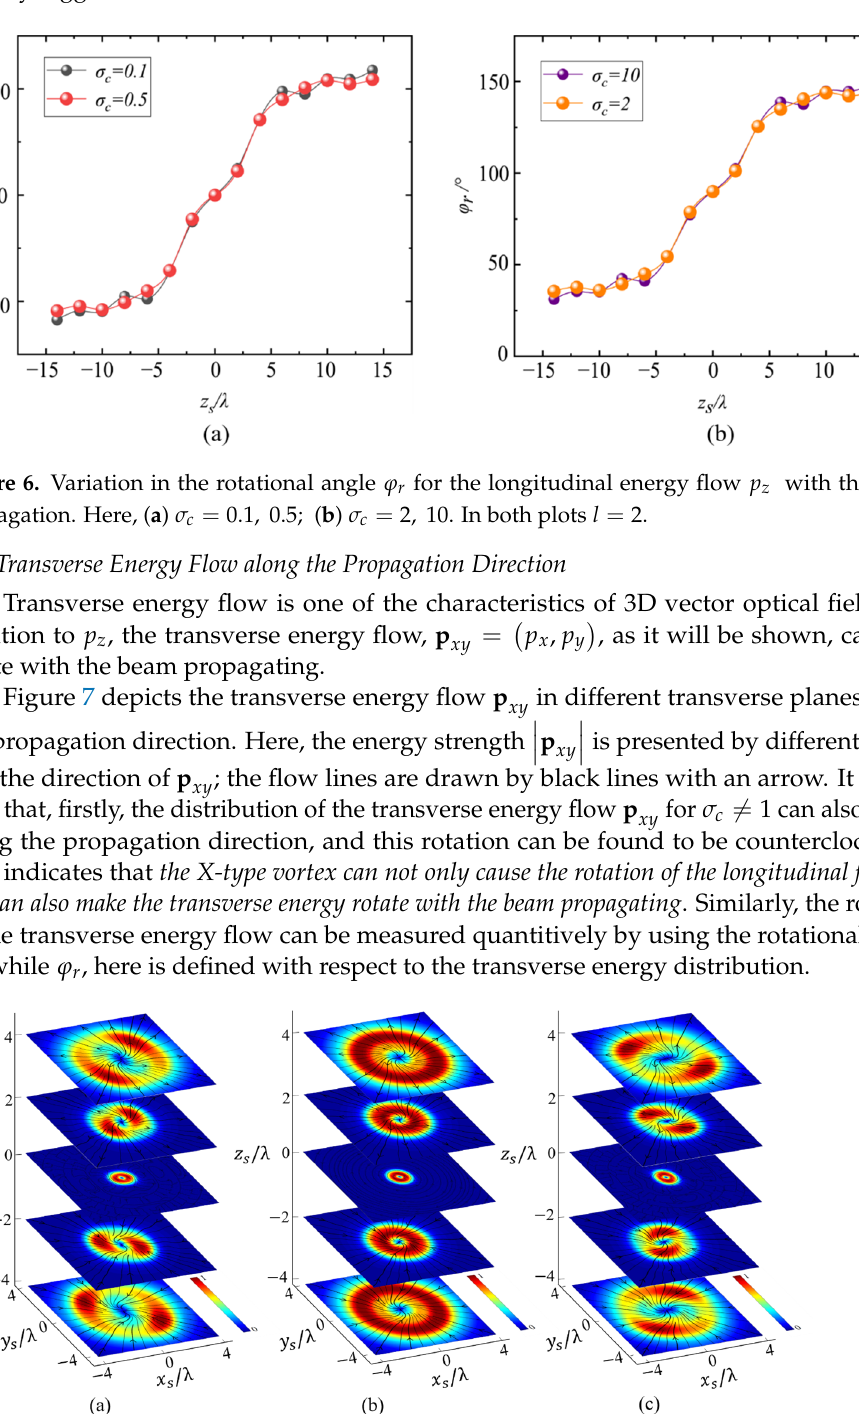
Figure 5. The longitudinal energy flow 𝑝 (cid:3053) along the propagation direction: ( a ) 𝜎 (cid:3030) = 0.5 ; ( b ) 𝜎 (cid:3030) = 1 ; ( c ) 𝜎 (cid:3030) = 2 . In all the plots 𝑙 = 2 .